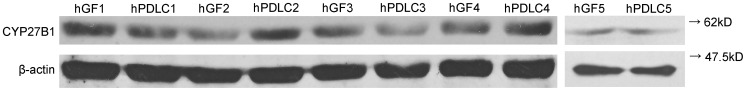
Protein expression of CYP27B1 in hGF and hPDLC.Protein expression of CYP27B1 was detected by Western blot in hGF and hPDLC from all five donors (donors are numbered 1–5). β-actin was used as an internal control.